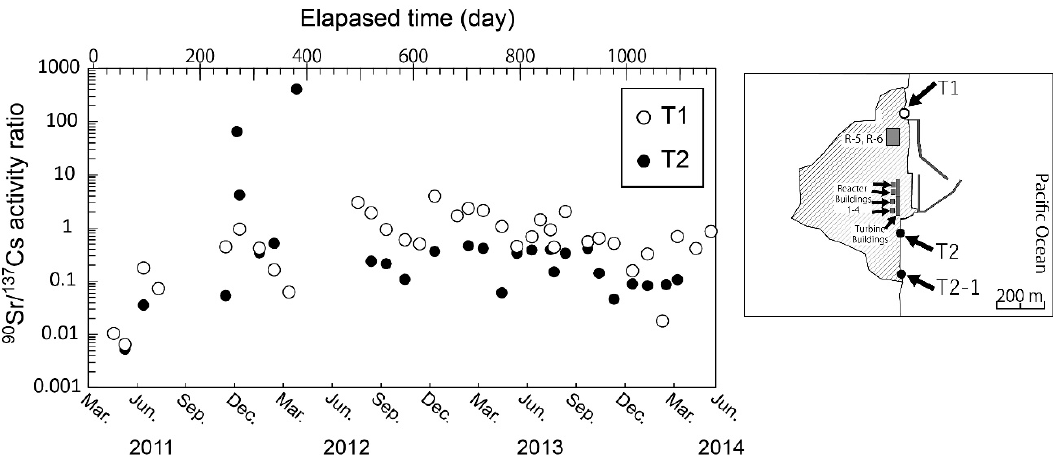
Figure 1. Temporal variations of strontium-90 / cesium-137 ( 90 Sr / 137 Cs) activity ratio in seawater from monitoring sites T1 and T2 (T2-1) in the Fukushima Daiichi Nuclear Power Plant (FDNPP) site [6]. T1 and T2 (T2-1) sites are located north and south of the discharge channel of the FDNPP, respectively.